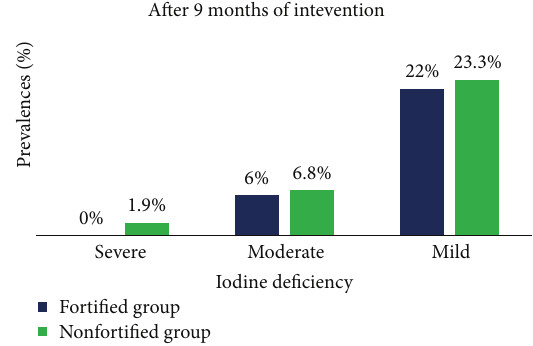
Figure 4: Prevalence of classes of iodine deficiency among fortified andnonfortifiedmilkgroupsafter9monthsofconsumptionofmilk.